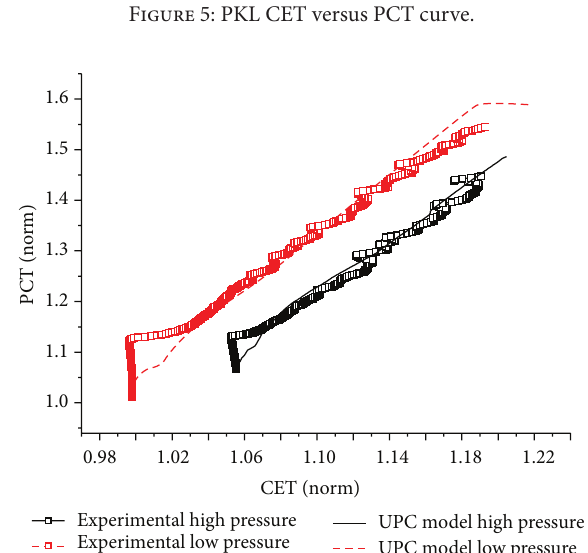
Figure 5: PKL CET versus PCT curve.